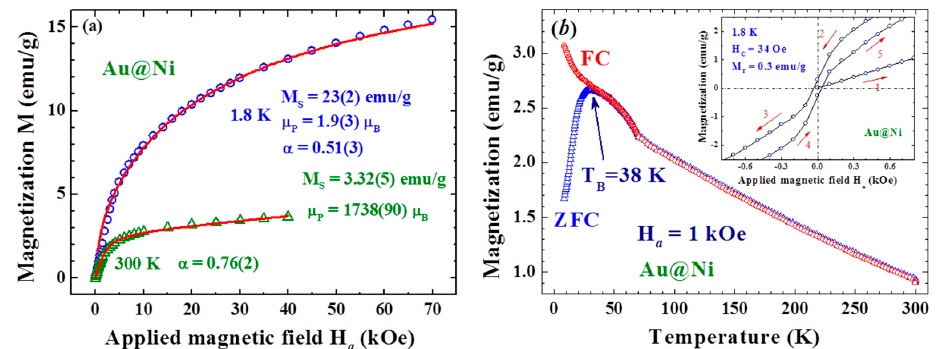
Figure 1. ( a ) isothermal magnetization curves M(H a ) taken at two representative temperatures of 1.8 and 300 K, where the solid lines indicate the fits of the data to the reduced Lagnevin profile discussed in the text; ( b ) isofield magnetization curves M(T) measured in warming with H a = 1 KOe, after FC (open circles) or ZFC (open triangles) from 300 to 2 K. The FC and ZFC curves depart from each other below 38 K, which marks the blocking temperature of the assembly. The inset shows the low field portion of the M(H a ) loop taken at 1.8 K, revealing a coercivity of 34 Oe and a remanence of 0.3 emu/g.